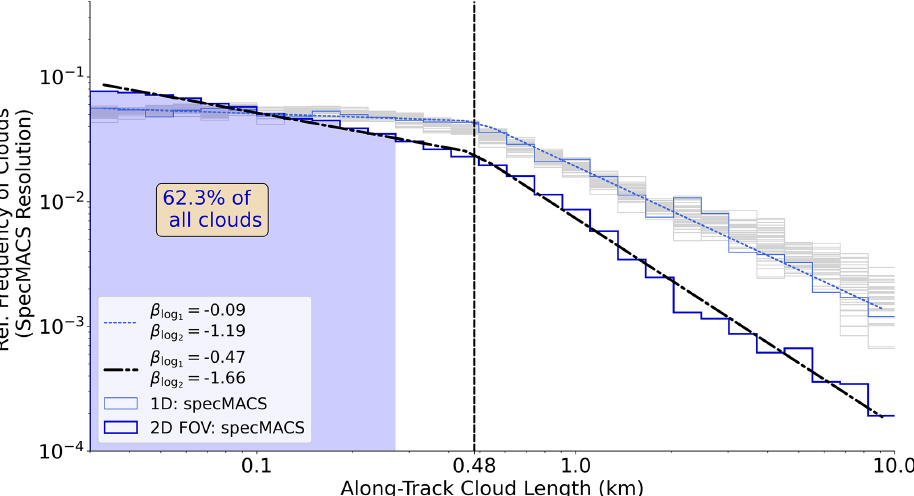
Figure 8. Comparison of along-track cloud size distribution from the imager (specMACS) based on 1D transects and the 2D horizontal field. Light blue and thin grey curves are identical to the 1D-based distributions in Fig. 6. The dark distribution and fitted curve represent the distribution for the maximum along-track cloud lengths, based on the entire 2D FOV, and the vertical–dashed line shows its scale break. Shaded domains specify cloud sizes, which are unresolvable for the radar at typical flight speed.